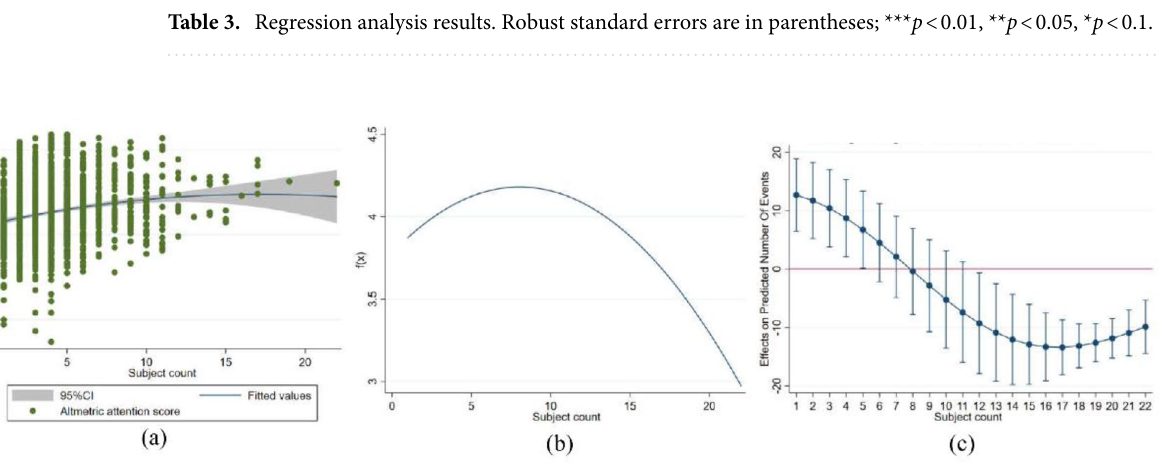
Figure 2. (a) Scatter plot and fitted curve of number of altmetric attention score vs. subject count (b) Regression function graph (c) Average marginal effects of subject count with 95%